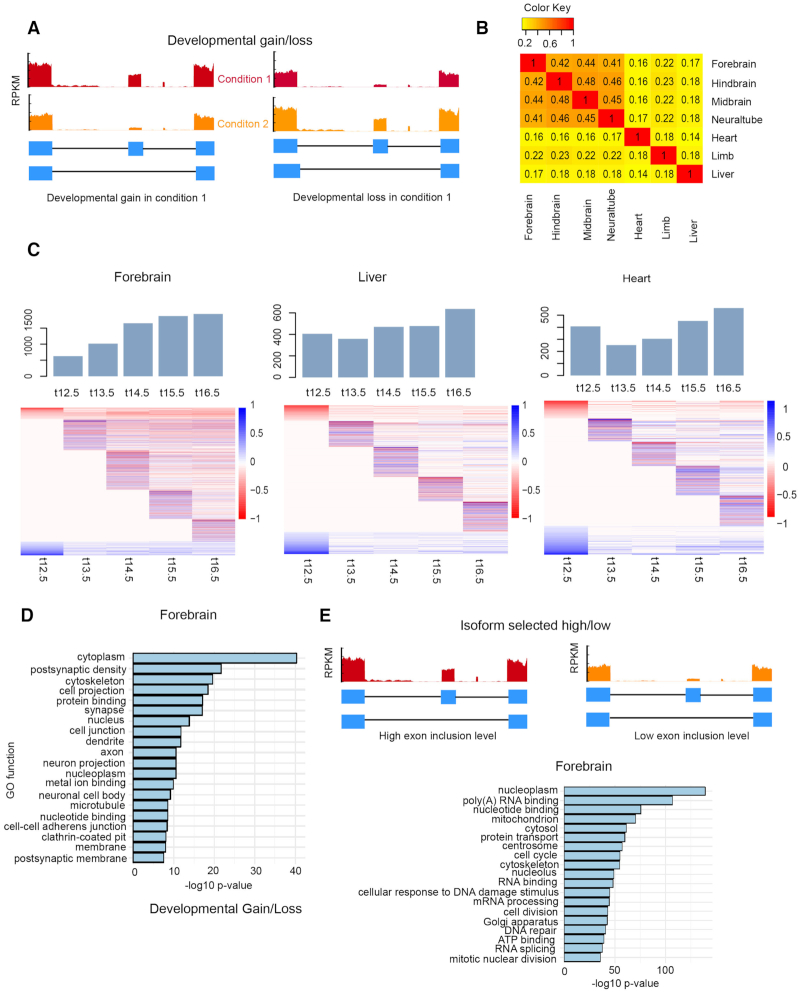
Alternative splicing events associated with tissue development. (A) Schematic illustrating developmentally associated skipped exons. (B) Overlap of developmentally associated alternative splicing events between tissues (C) Number of significant alternative splicing events identified across 7 developmental time points for several mouse tissues. Heat maps show the differential exon inclusion level (ΔPSI) by comparing each time point to earliest time point in skipped exons (row). Bar graph shows the proportion of lineage-specific AS genes. (D) Ontology analysis of developmentally associated AS genes in forebrain. Data are derived from ENCODE database (32) (Supplemental Table S1) and analysed using rMATs (33). (E) Ontology analysis of isoform selected high/low AS genes in forebrain.